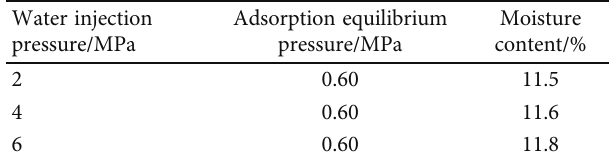
Table 2: Moisture content of the coal